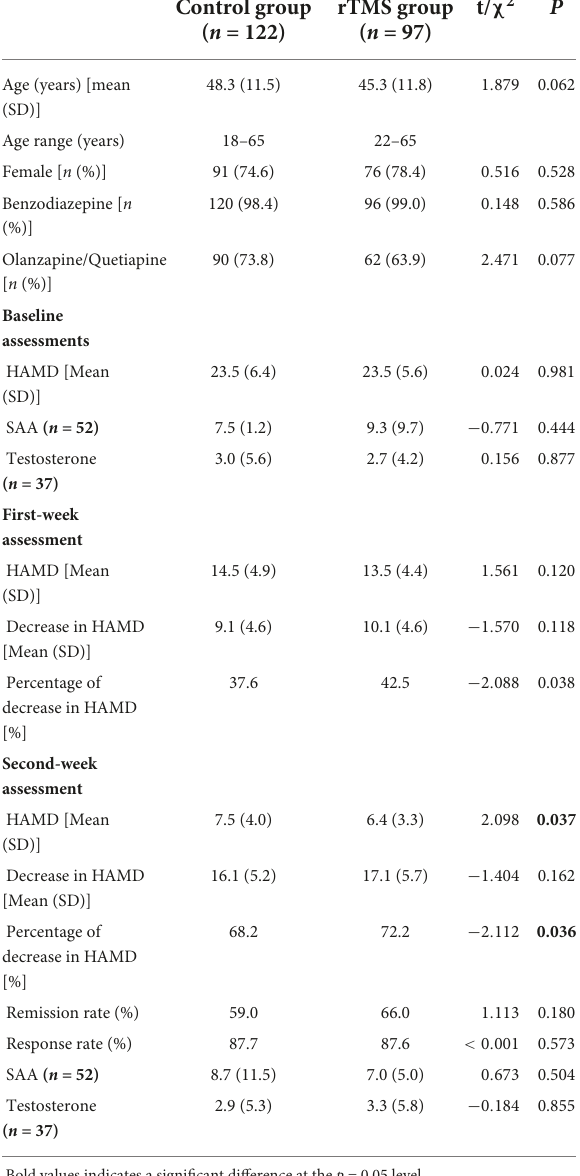
TABLE 1 Demographic, Hamilton Rating Scale for Depression (HAMD) score, serum amyloid A (SAA), and testosterone in the control and the repetitive transcranial magnetic stimulation (rTMS) groups.